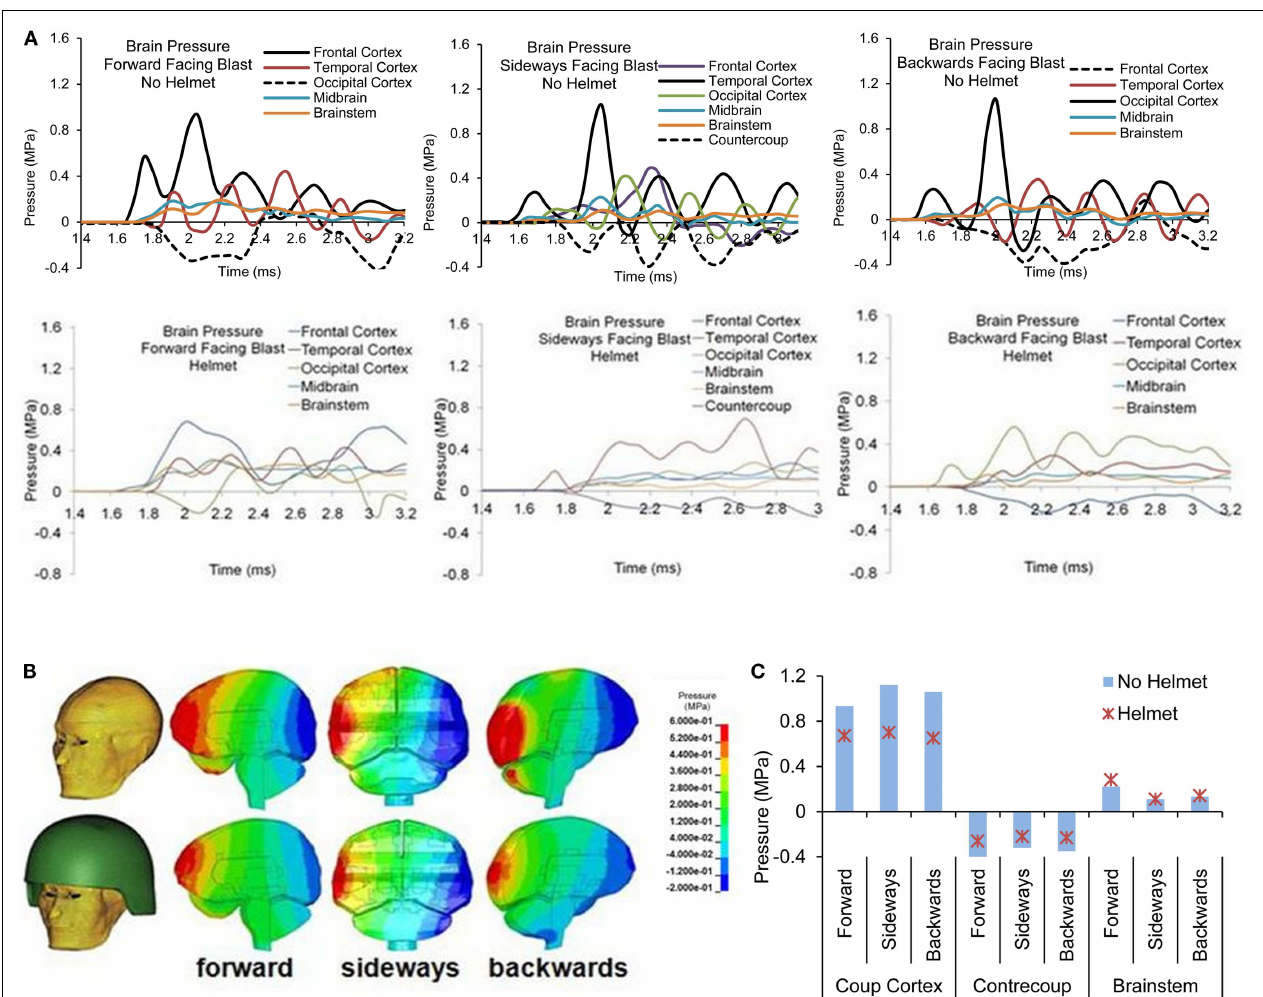
FIGURE 10 | (A) Pressure time histories at various regions of the brain in head with and without helmet due to forward, sideways and backwards blast (B) Pressure contours across the brain at the time when the pressure exhibits the coup and contrecoup phenomenon, and (C) Comparison of the highest positive and lowest negative pressure and brainstem